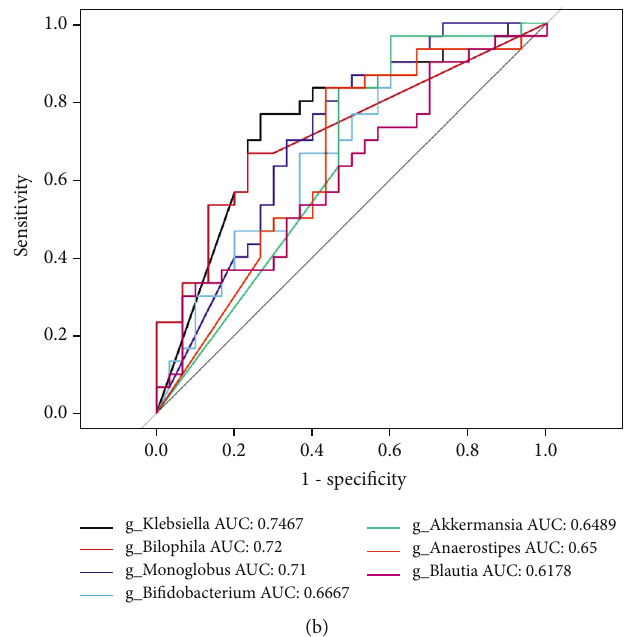
Figure 8: (a) Random forest analysis at genus level. (b) ROC curve analysis of the 10 di ff erent bacterial groups at genus